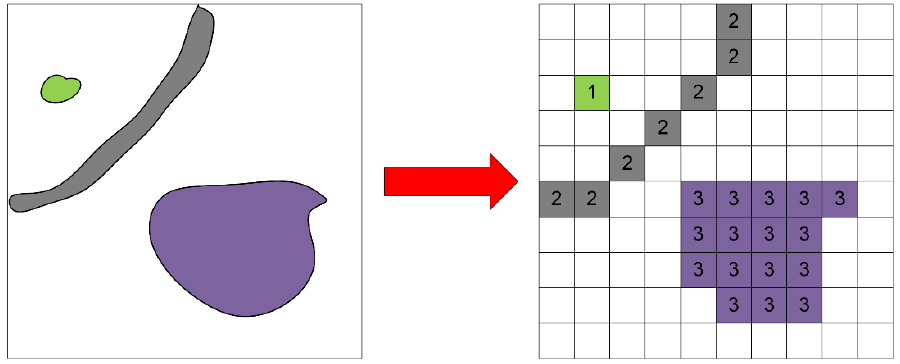
Figure 4. Occupied grid map.